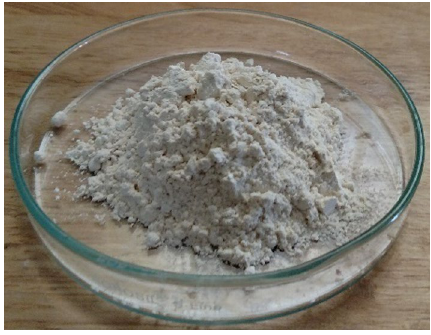
Fig. 4 Powdered adsorbent having particle size 0.1